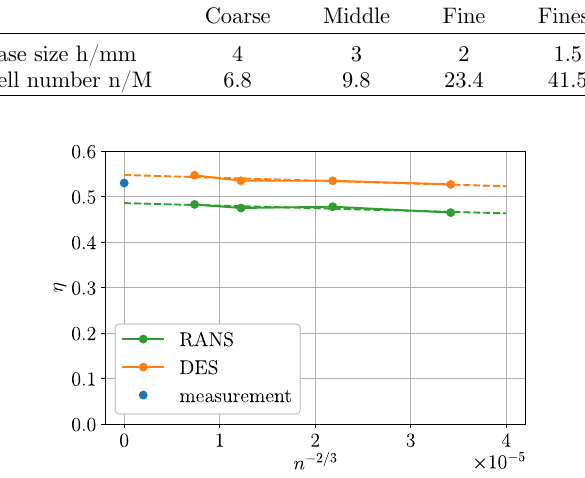
Figure 11. Convergence of the total-to-static ef fi ciency g for RANS simulations (blue) and DES simulations